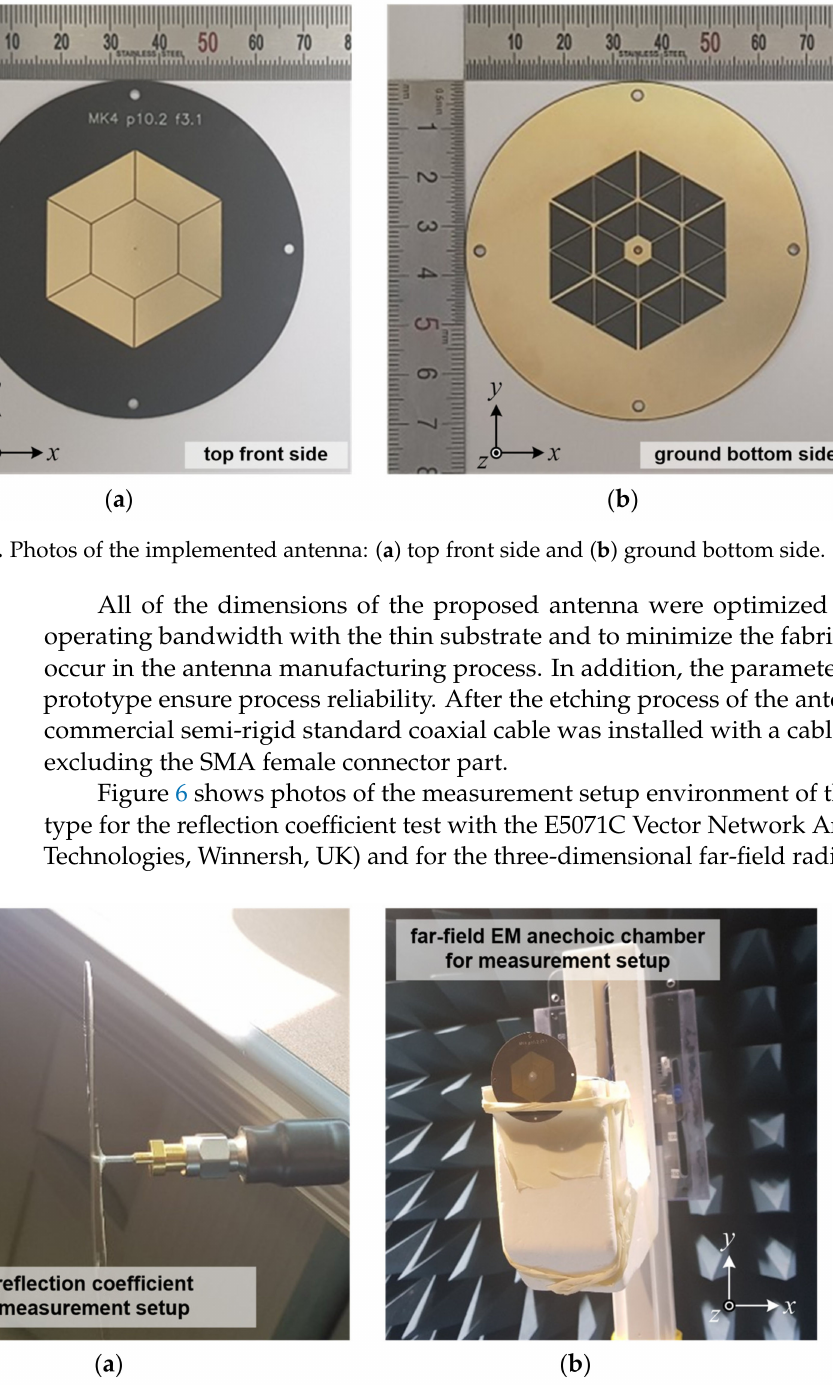
Figure 6. Photos of the measurement setup for the implemented antenna: ( a ) side view for reflection coefficient test and ( b ) front view for three-dimensional far-field radiation pattern test in anechoic